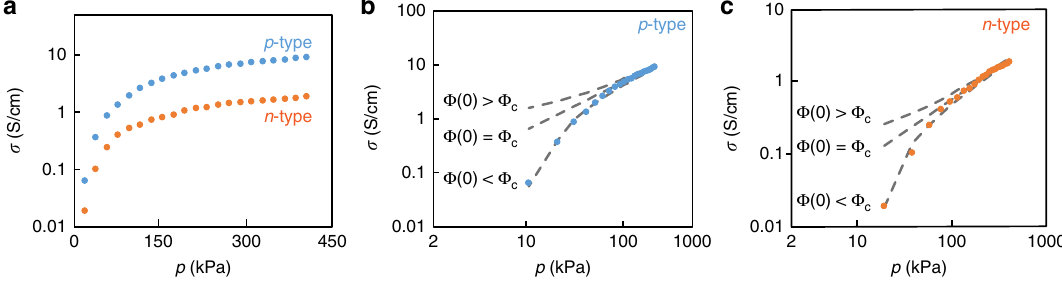
Fig. 2 The electrical conductivity of composite threads was improved under compression. a The electrical conductivity σ of both n -type and p -type threads were improved with increasing applied compression pressures p in a log-linear plot. b , c Log-log plots demonstrate an asymptotic power-law relation between conductivity and pressure at high pressures. For the pure theoretical power-law fi t line (central gray dash) the volume fraction is equal to the critical value with power-law exponent s = 0.87 (0.90) for p - ( n -) type threads according to modi fi ed percolation theory in Eq. 2. The downward trend of experimental data matches the fi t lower gray dash curve, implying that the initial concentration is just below the percolation threshold for conduction Φ (0) < Φ c . Conversely, if the conductivity were to saturate at low pressure (upper gray dash curves), this would imply that the initial concentration exceeded the percolation threshold Φ (0) > Φ c